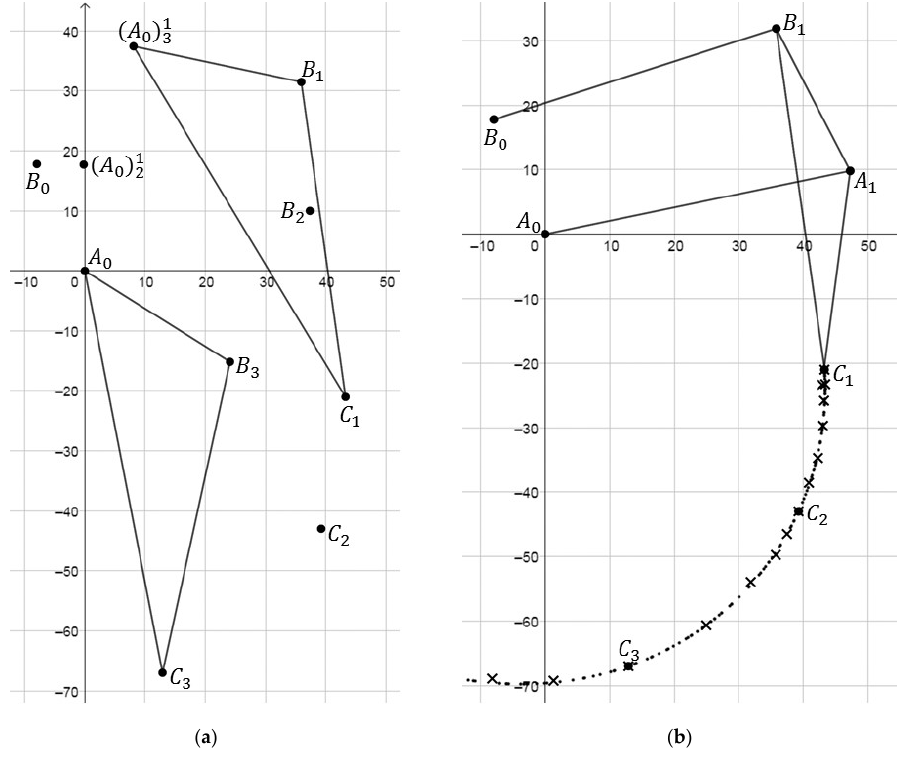
Figure 12. A scheme for determining the second linkage: ( a ) Triangles of the relative positions C0; ( b ) synthesized mechanism and resulting trajectory passing through the selected points C1, C2, C3.